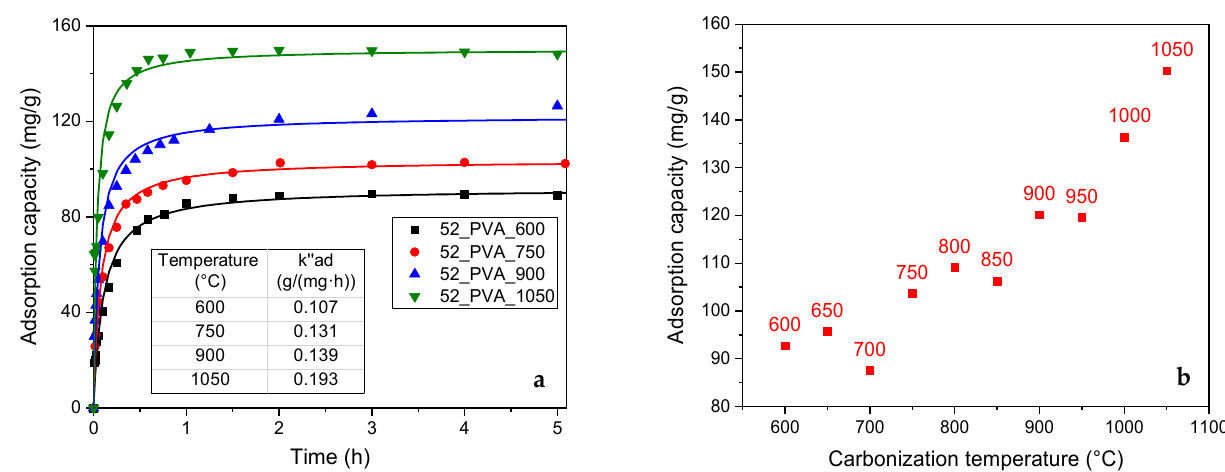
Figure 6. ( a ) Results of adsorption tests in phenol removal from an aqueous solution with fitting by the PSO model. ( b ) Relationship between adsorption capacity and carbonization temperature for the 52_PVA resin annealed at different temperatures.